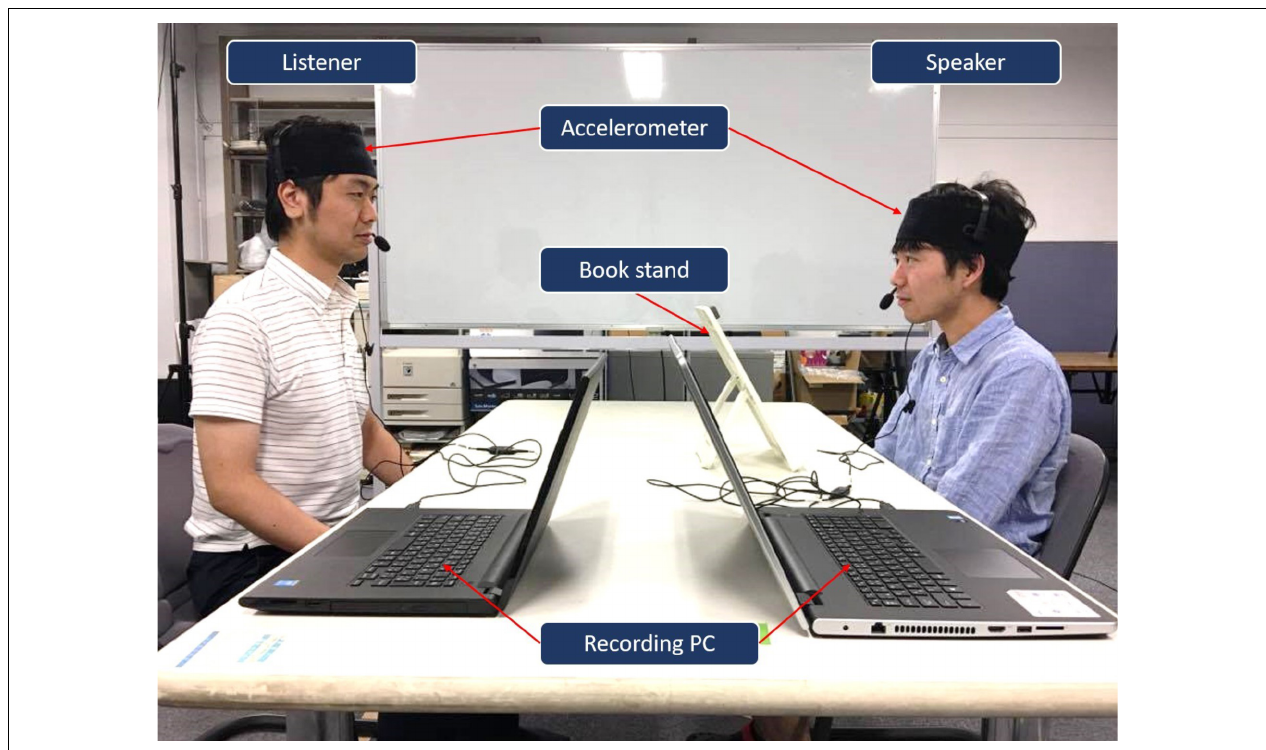
FIGURE 3 | Experimental setting. Written informed consent was obtained from each individual for the publication of this